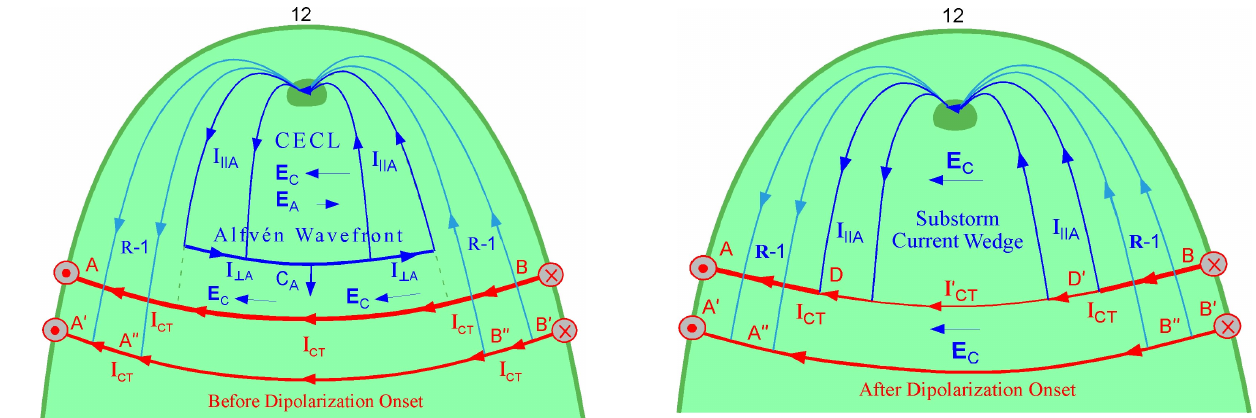
Fig. 7a. (a) depicts the CECL model before dipolarization onset. Dipolarization onset in the CECL model is initiated by the CECL in- teracting with the plasma sheet to disrupt the cross-tail current in the dipolarization region. The CECL is a closed Cowling electrojet cur- rent loop formed by the divergence and convergence, respectively, on the dusk-side and dawn-side of the Cowling electrojet channel. The Alfv´en wavefront leads the propagation of the CECL towards the plasma sheet. Inside the CECL, the E-field is E 0 = E C + E A . The energy flow to power the CECL model before the dipolarization onset is discussed in Sect. 5.1.